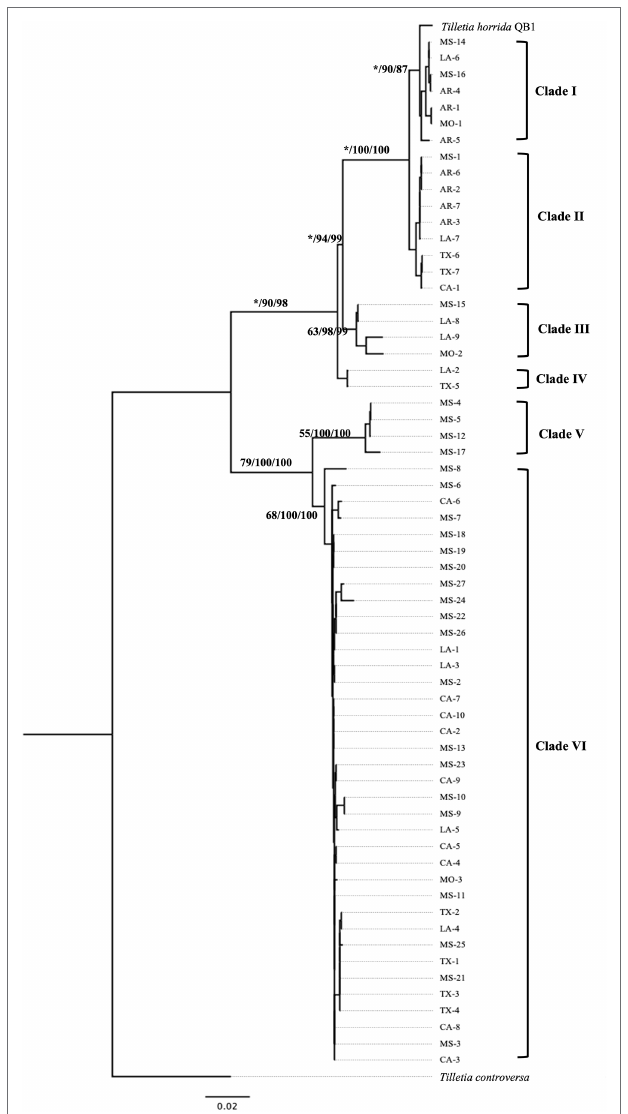
FIGURE 5 | Neighbor-joining phylogenetic tree of concatenated sequences with protein coding genes EF -1 α and RPB1 of 63 isolates collected from Arkansas (AR), California (CA), Louisiana (LA), Mississippi (MS), Missouri (MO), and Texas (TX) in the US. T. horrida strain QB1 was used as a reference isolate and T. controversa strain DAOMC 236426 was used as an outgroup. The scale bar represents the number of substitutions per site. The value on the branches indicates the percentage of trees based on 1,000 bootstrap replicates on ML/NJ/ME, respectively. Only branches values with >50% replicates are show; “*” indicates that the branch value is less than